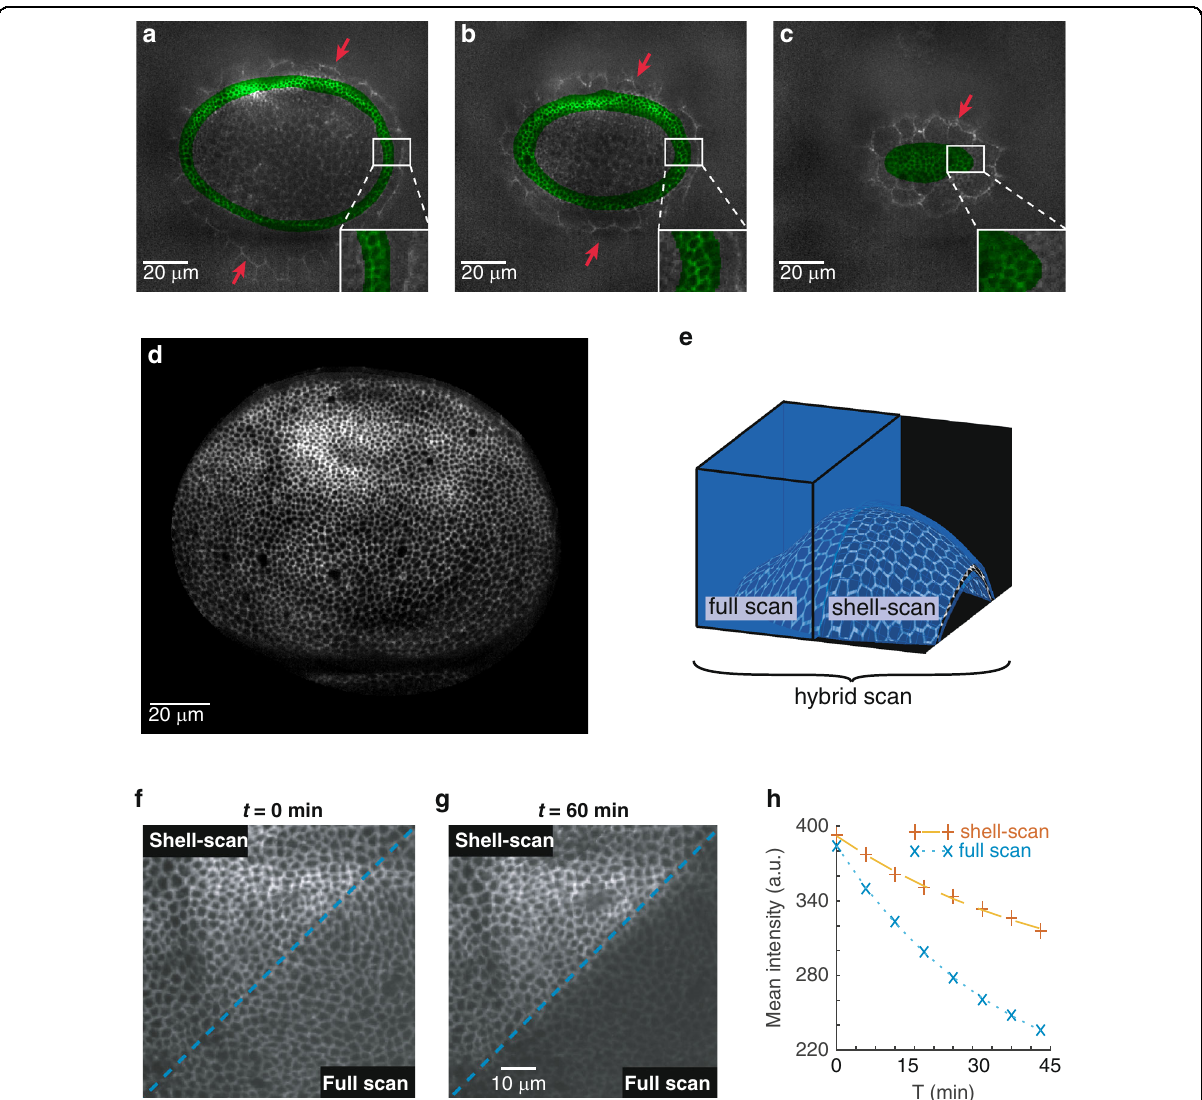
Fig. 2 Shell-scan around the surface of interest. a – c Overlay of full scan XY sections of the tissue (gray) with the estimated shell (green) at 3 different planes. Imaginal cells are well encapsulated by the shell, while cells of the overlying peripodial membrane (red arrows) are properly discarded. d Maximum intensity projection of the normalized signal (equation (1)) acquired with the shell scan on a wing imaginal disc. e – h Comparing image acquisition with shell scan and full scan. A hybrid scanning strategy is performed to simultaneously image half of the tissue in full scan and half in shell-scan ( e ). f , g Maximum intensity projection. While the two adjacent zones are initially indistinguishable ( f ), bleaching is more prominent in the full scan zone after 60 min of continuous imaging ( g ). h Quanti fi cation of the bleaching process showing the temporal evolution of the maximum intensity projection averaged over the full scan or shell-scan